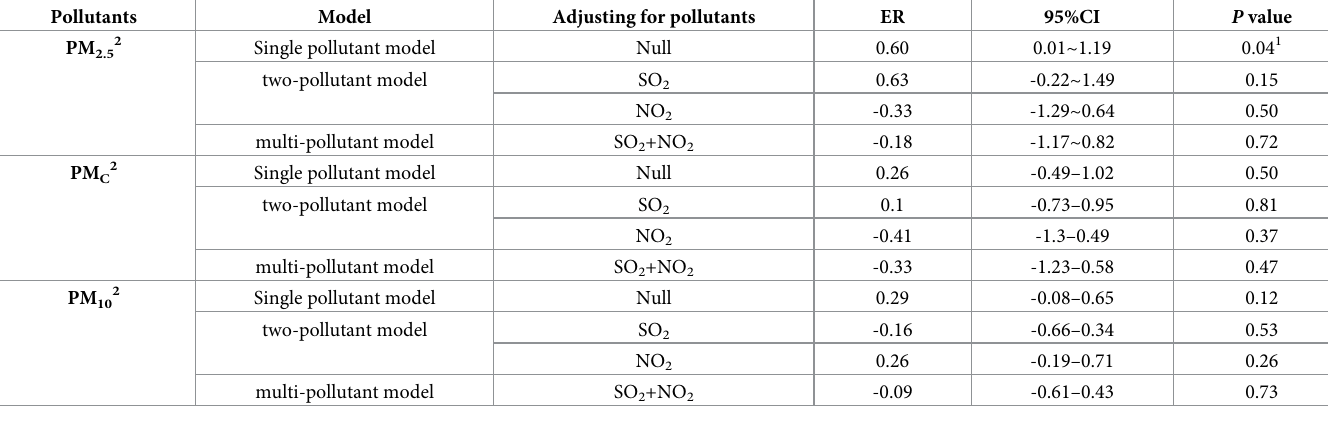
Table 3. The percent change of daily stroke morbidity in every a 10 μ g/m 3 increase in PM concentration under different pollutant models. Pollutants